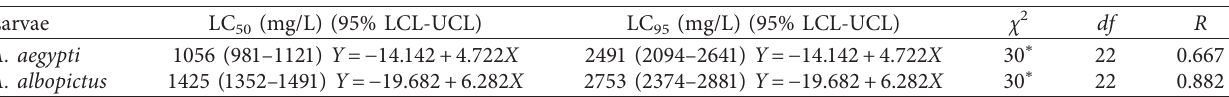
Table 2: Larvicidal activity of Clitoria ternatea flower extracts against early 4th instar larvae of Aedes aegypti and Aedes albopictus .